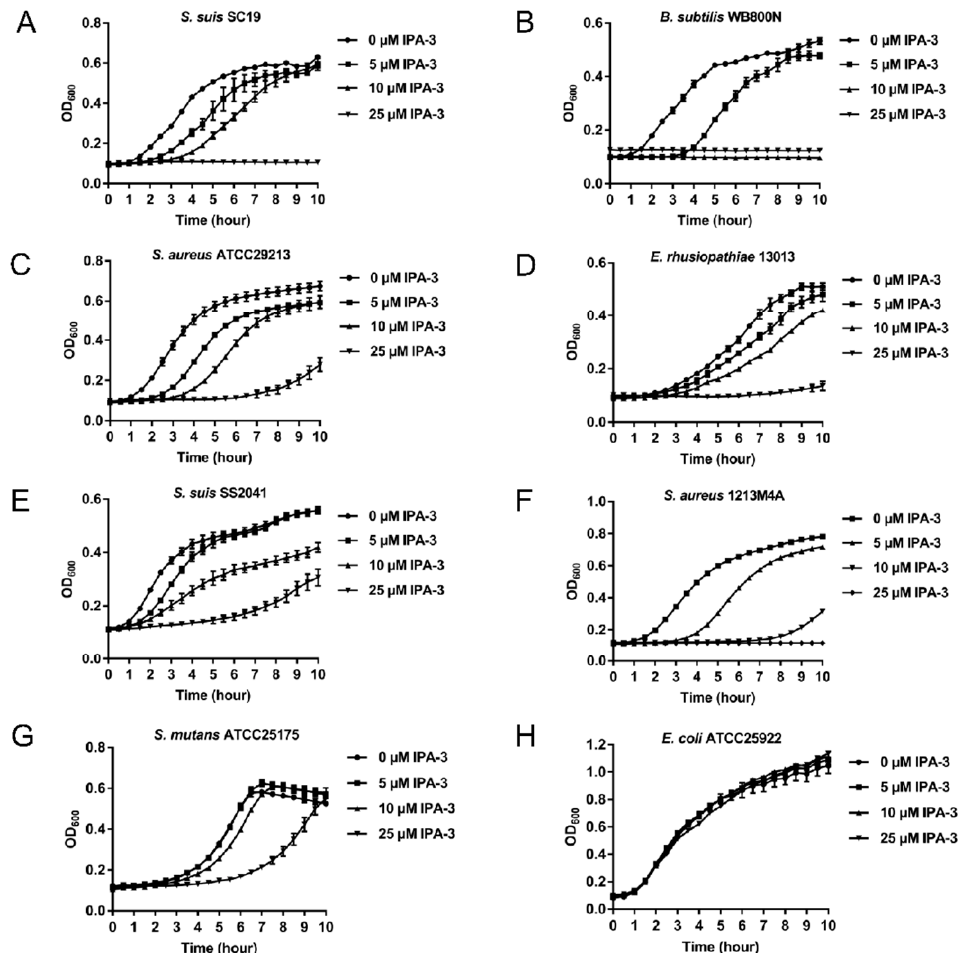
Figure 4. Antimicrobial efficacy of IPA-3. Cells of ( A ) S. suis SC19, ( B ) B. subtilis WB800N, ( C ) S. aureus ATCC29213, ( D ) E. rhusiopathiae 13013, ( E ) S. suis SS2041, ( F ) S. aureus 1213M4A, ( G ) S. mutans ATCC25175, and ( H ) E. coli ATCC25922 were subcultured from a culture grown overnight in an appropriate medium in the absence or presence of the indicated concentrations of IPA-3. The growth was monitored using an automatic growth curve analyzer. The data presented are the means ± standard errors of the means ( n =